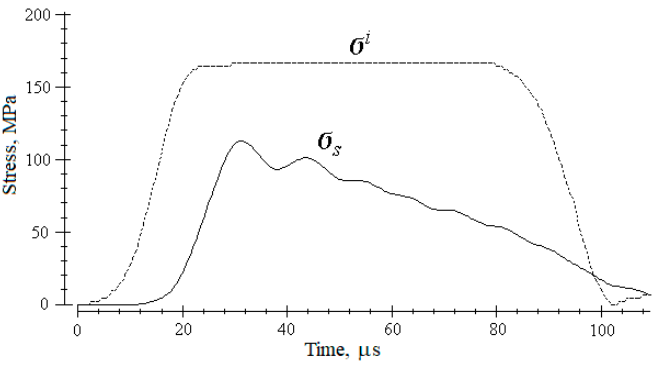
Figure 5. The parametric process of stress development in a specimen σ s in case of its destruction in comparison with a loading pulse σ i .